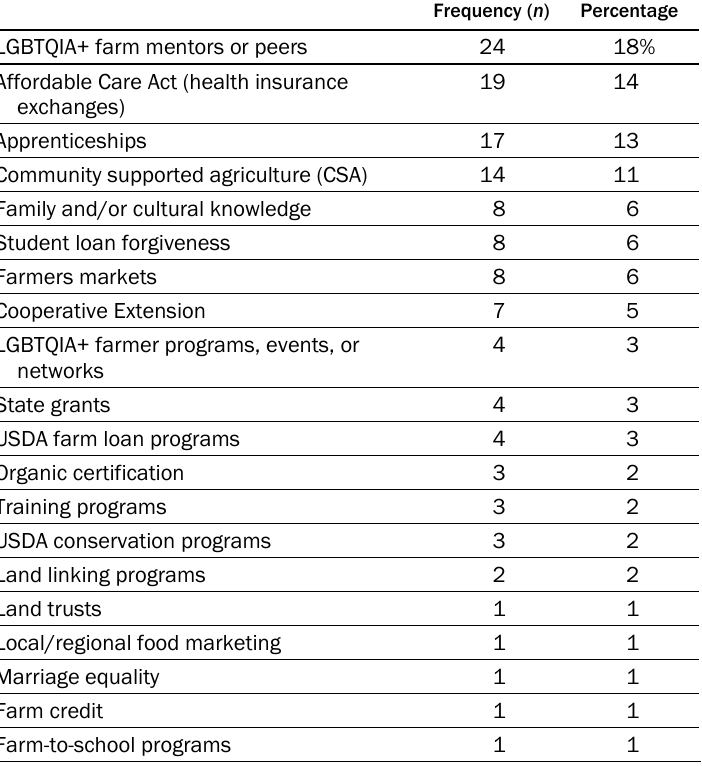
Table 5. What Helps Queer Farms Be